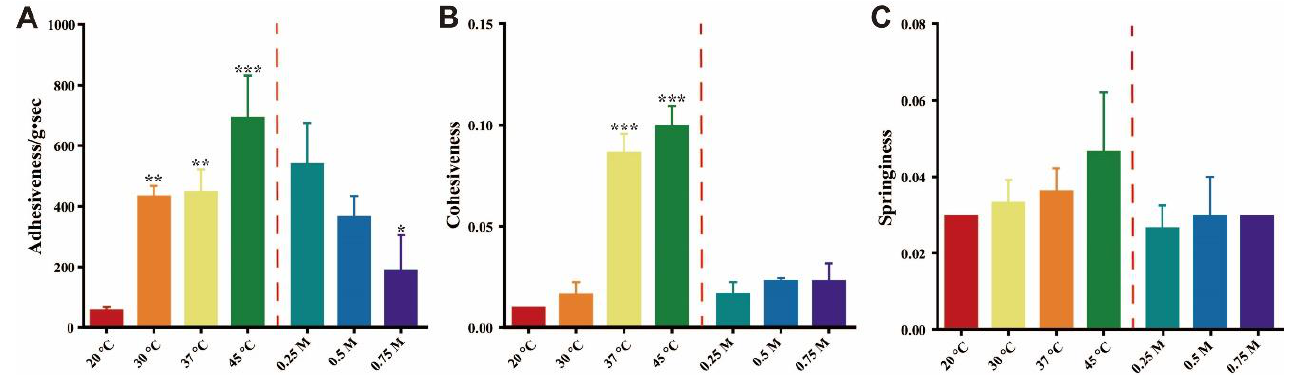
Figure 7. Texture parameters: ( A ) adhesiveness, ( B ) cohesiveness and ( C ) springiness of the ACM gels from amorphous ACM at different temperatures and ionic strengths. Results are expressed as the mean ± SD ( n = 3, * p < 0.05, ** p < 0.01 and *** p < 0.001 vs. 20 °C in temperature effect experiments or vs. 0.25 M in ionic strength effect experiments).